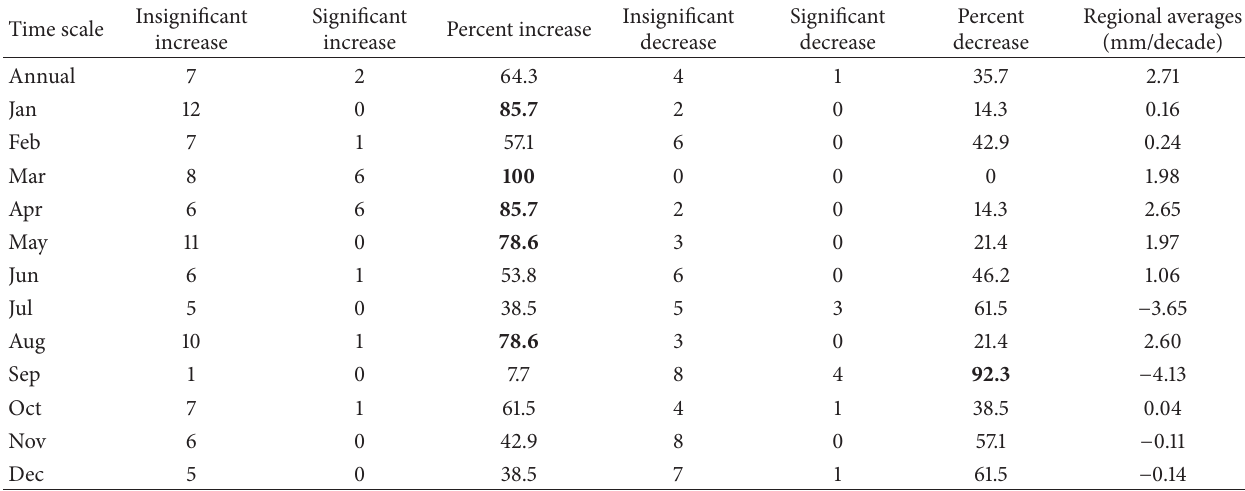
Table 5: Trend and regional averages of annual and monthly precipitation.